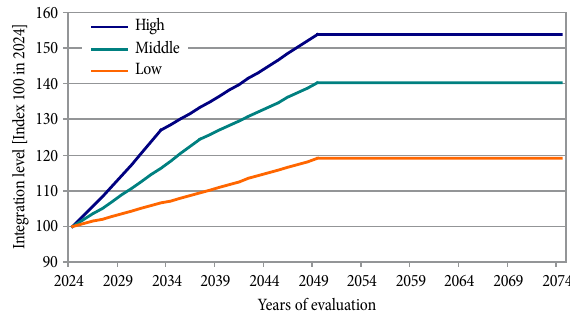
Fig. 7. Scenario trend development (adapted from Annema et al. 2007; Larsen, Skougaard 2010)